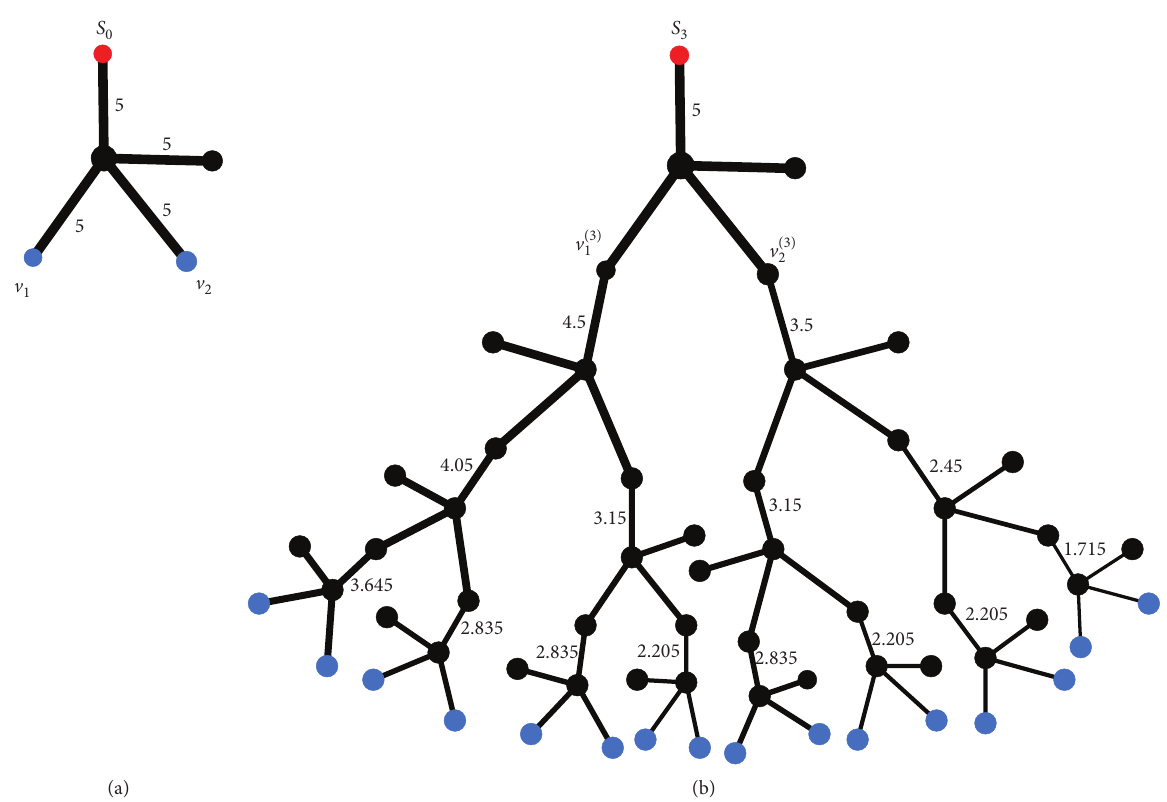
Figure 2: The graphical representations of (a) G Thickness of the lines reproduces edge weights: the thicker the line, the larger the weight.